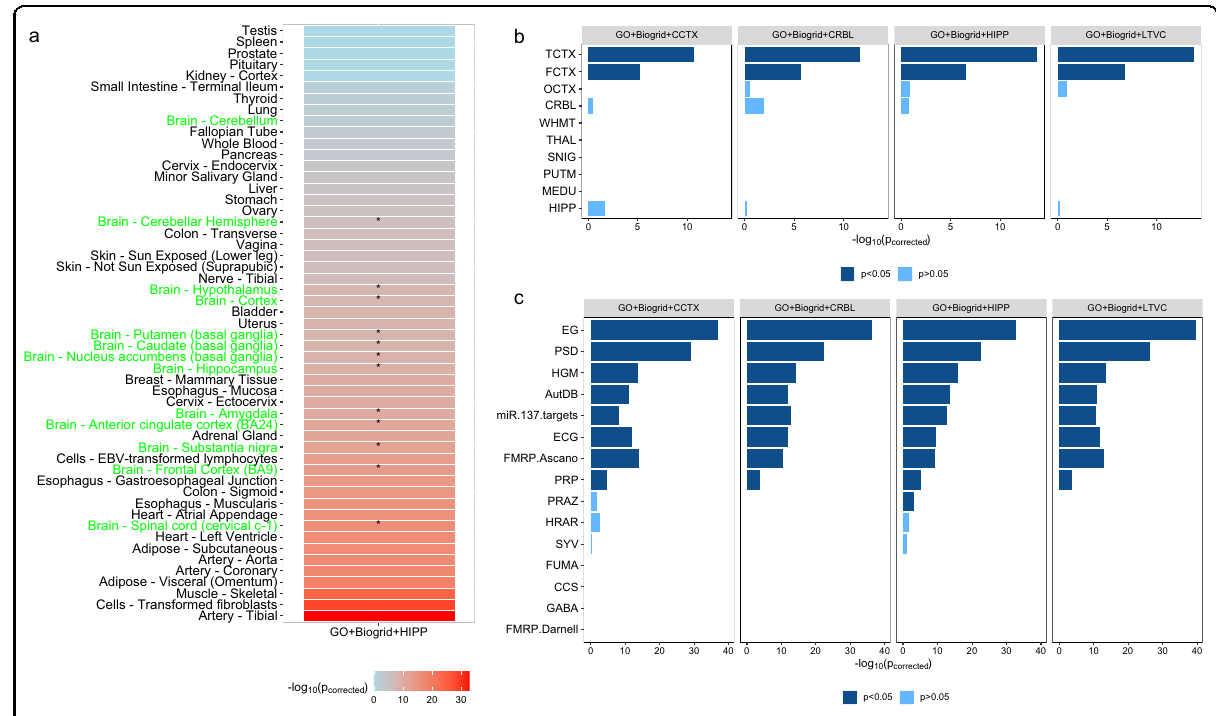
Fig. 4 Comparing the tissue speci fi city of HRGs and LBGs predicted by integrating GO, BioGRID, and four types of tissue-speci fi c PPI network. a HRGs predicted by four forms of network integration are all highly expressed in the same brain tissues compared to LBGs. “ * ” denotes that the predicted HRGs are signi fi cantly enriched in the brain tissues. Tissue names in green represent brain tissues. b HRGs predicted by four forms of network are all highly expressed in the same two brain regions compared to LBGs. c HRGs predicted by GO and PPI networks from BioGRID and hippocampus are enriched in nine SCZ-related gene sets, and HRGs predicted by other forms of network are enriched in eight SCZ-related gene